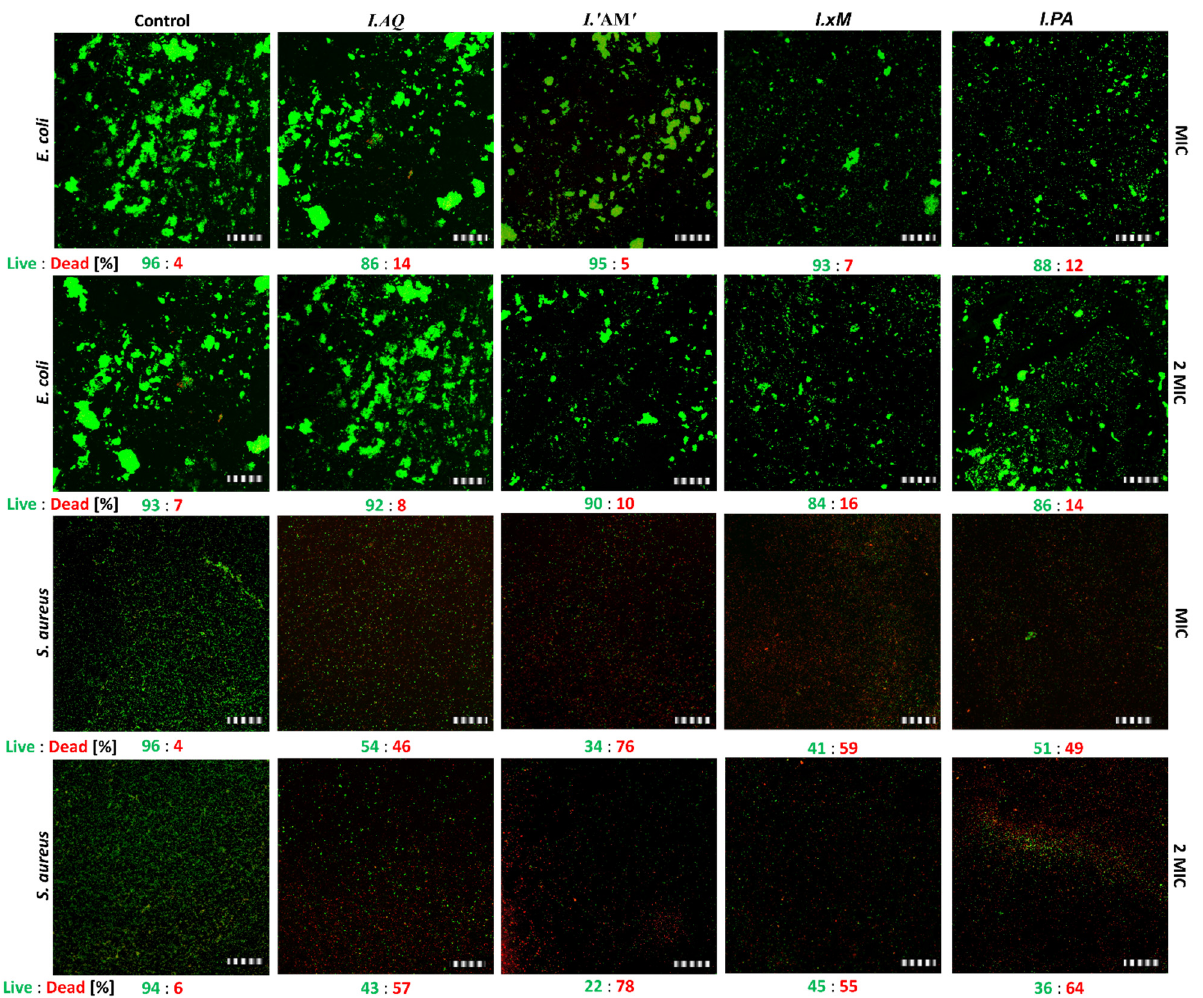
Figure 6. E . coli and S . aureus killing percentage in the biofilm condition analysed by counting the live/dead bacteria. Legend: I.PA — I. paraguariensis ; I.AQ — I. aquifolium ; I.’AM’ — I. aquifolium ‘Argentea Marginata’; I.×M — I. × meserveae ‘Blue Angel’.